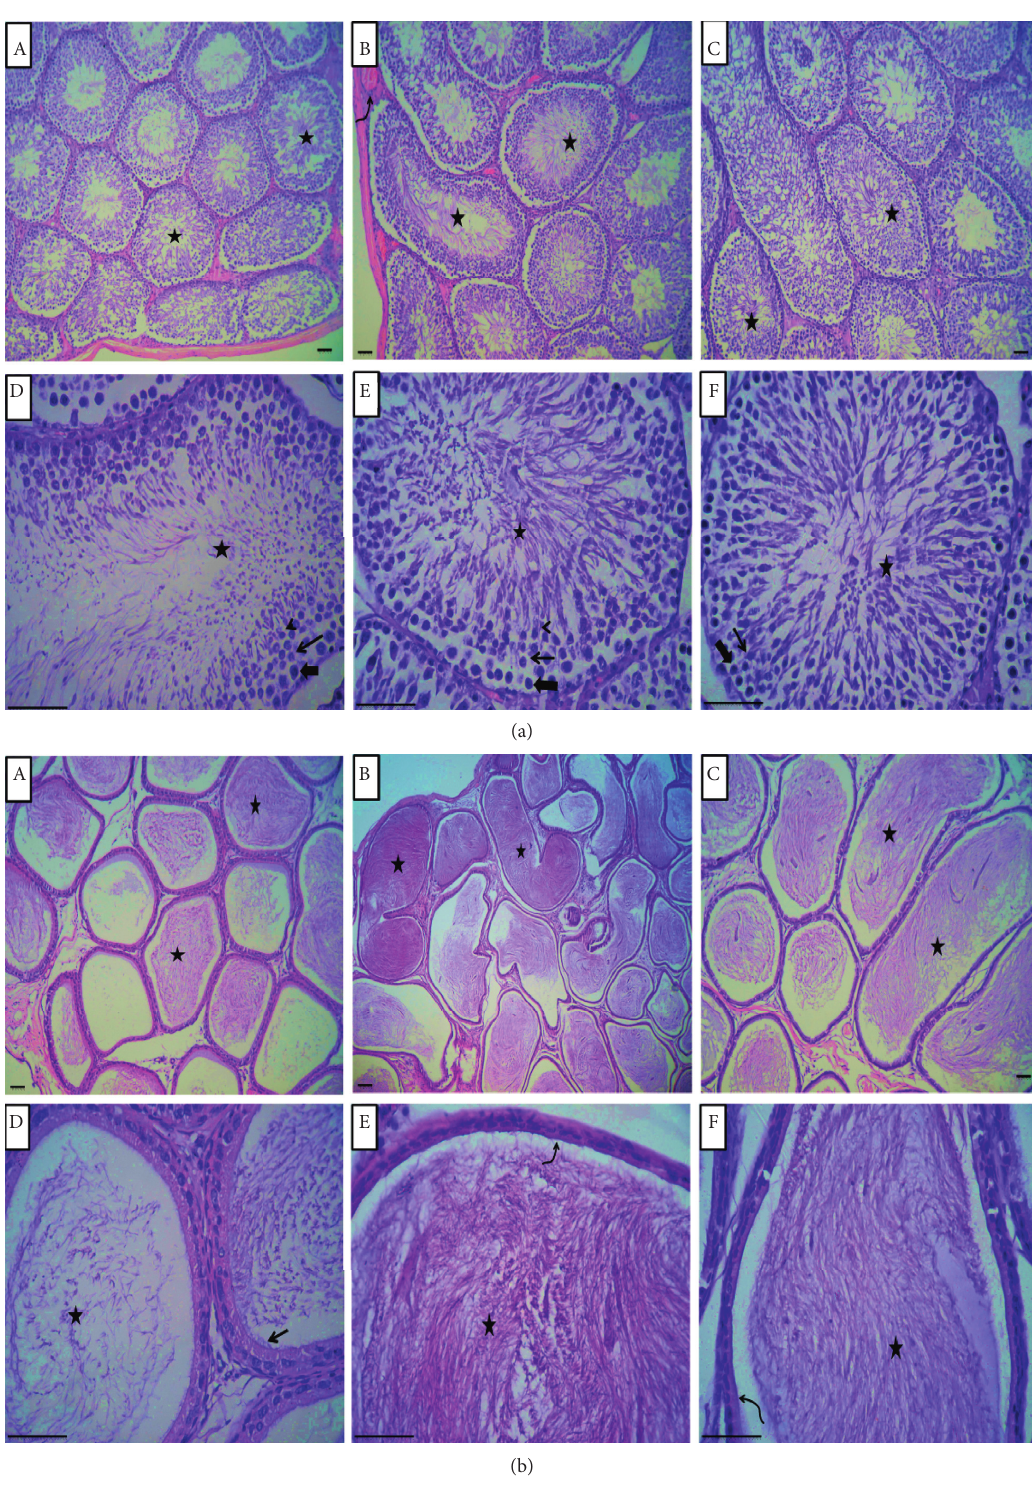
Figure 6: Histological changes in the testes and epididymides. (a) Rat testes. (A, D) Testes of the control group showing normal histomorphology of spermatogonia (thick arrow), spermatocytes (arrow), spermatid (arrow head), and mature sperms within lumen of seminiferous tubules (asterisks). (B, E) Testes of rats after prolonged light exposure illustrating normal spermatogonia (thick arrow), hyperactive spermatogenesis (arrow), and spermiogenesis (arrow head) with large number of sperms within lumina (asterisks) and normal testicular blood vessels (curved arrow). (C, F) Testes of rats after prolonged dark exposure showing normal spermatogonia (thick arrow), spermatocytes (arrow), and numerous numbers of mature spermswithinmost seminiferous tubules lumina(asterisks). (b)Rat epididymis. (A,D) Photomicrographof epididymisofthe control group showing stored sperms within tubular lumina (asterisks) and pseudostratified columnar epithelium with stereocilia lining epithelium (arrow). (B, E) Ep- ididymisoftheprolonged light-exposedgroup revealingclumpsofspermatozoawithinepididymallumina (asterisks)with pseudostratifiedcolumnar epitheliumliningtubules(curvedarrow).(C,F)Photomicrographofepididymaltubulesintheprolongeddark-exposedgroupshowinglowcolumnar to cuboidal lining epithelium (curved arrow) and numerous numbers of spermatozoa within epididymal lumina (asterisks). Scale bar � 250 µ